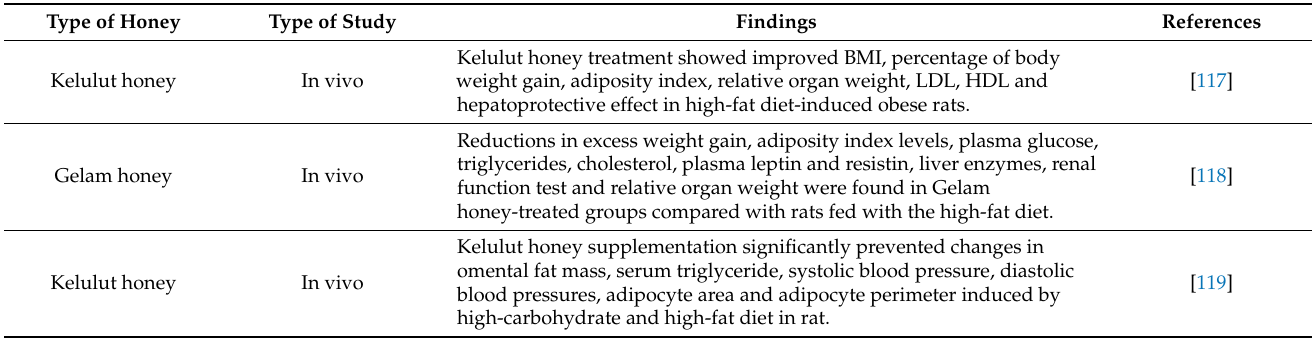
Table 8. Summary of anti-obesity